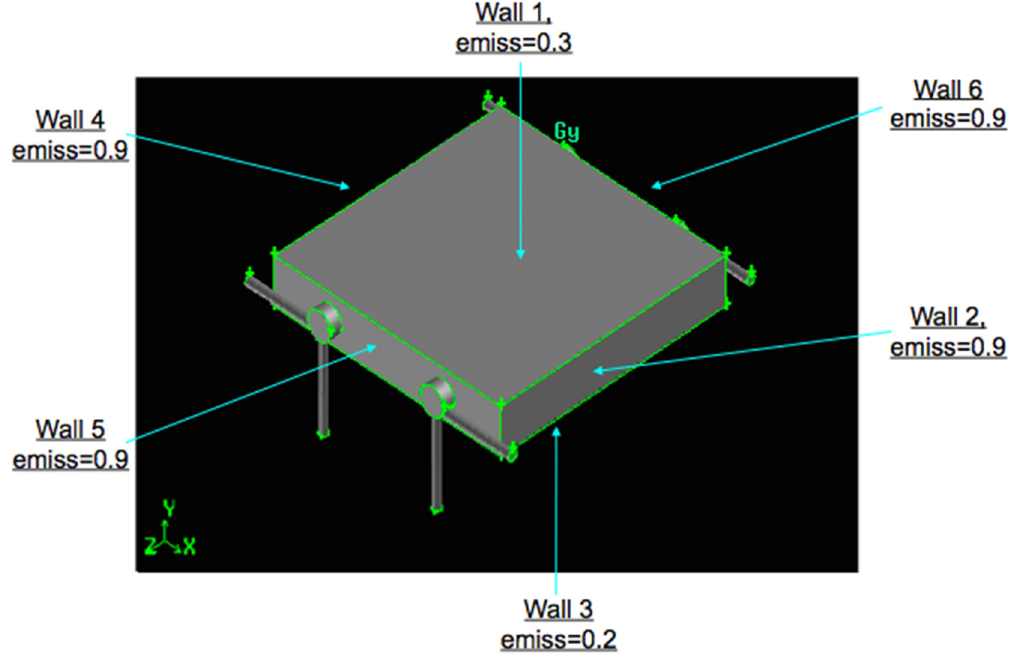
Figure 4. Swirling combustor converter, Z / D = 11, emissivity